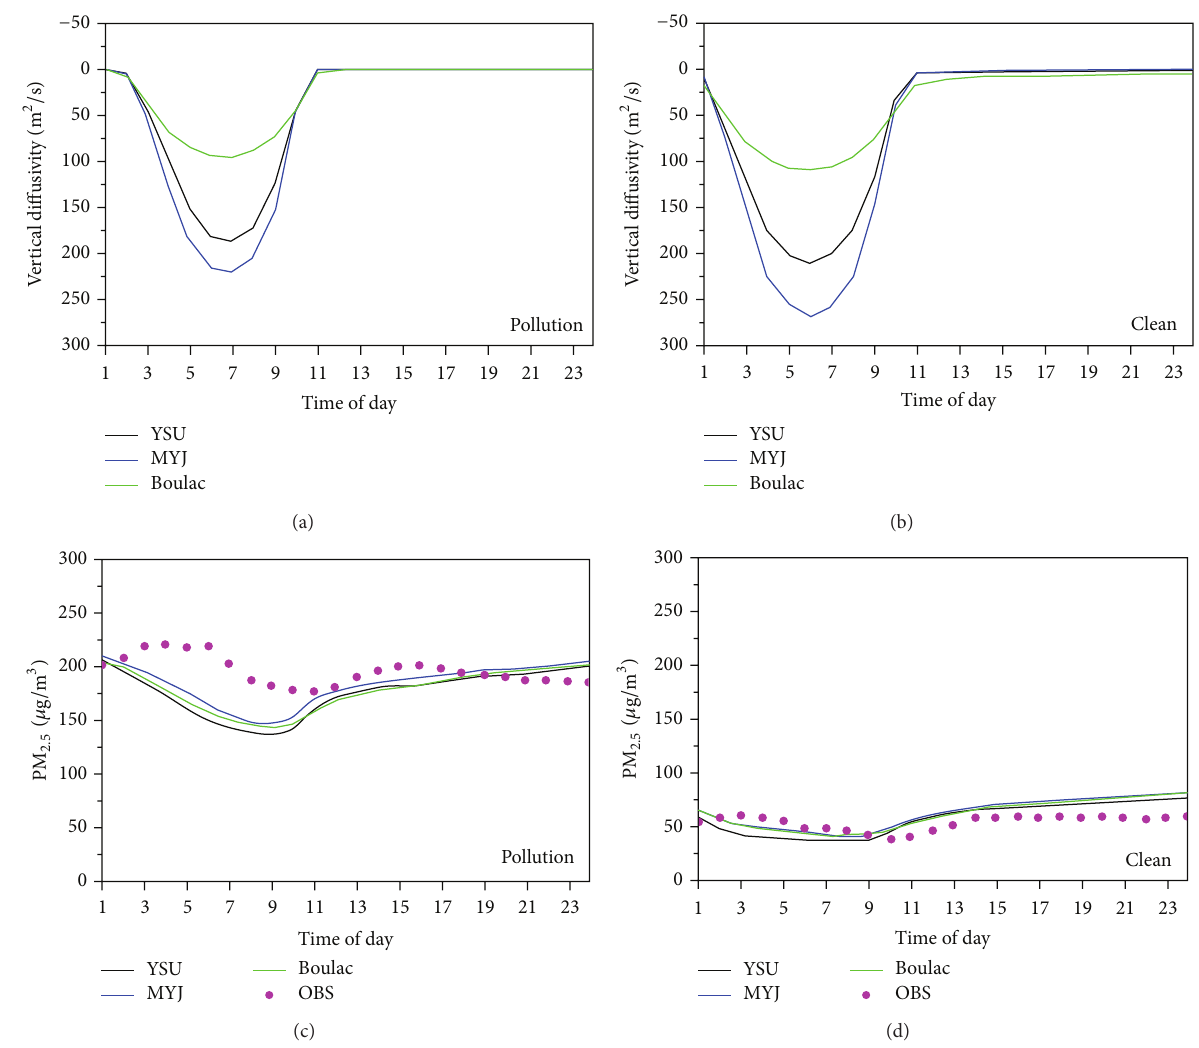
Figure 8: Diurnal variations of PM 2.5 ((a)-(b)) and vertical diffusivity